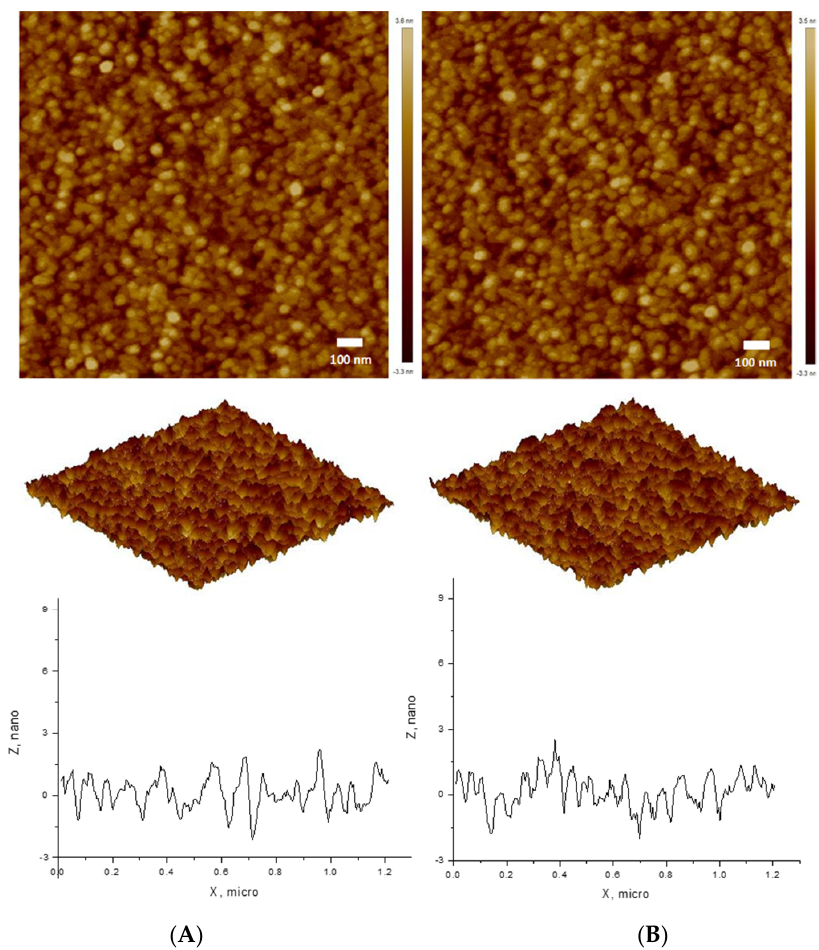
Figure 4. AFM tapping mode of 2D and 3D height images, and cross-section of ( A ) CAPE-loaded non-crosslinked micelles and ( B ) CAPE-loaded crosslinked micelles.